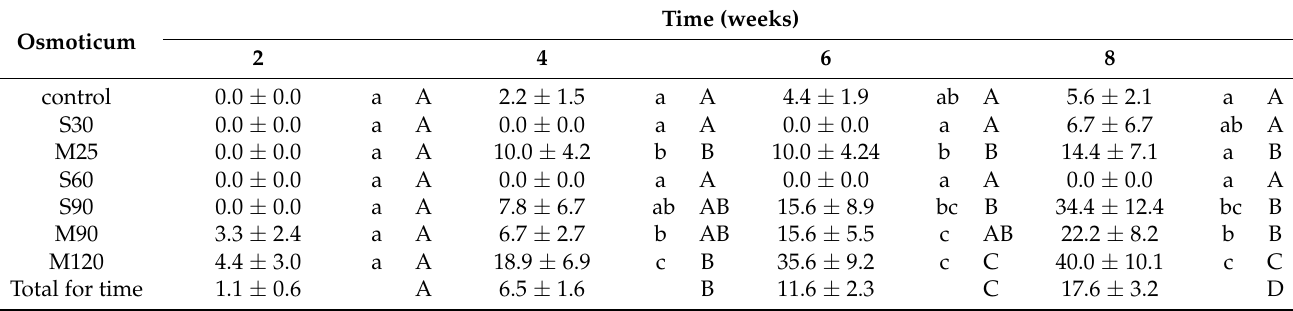
Means with the same lowercase letter within a column or means with the same uppercase letter within a row are not significantly different at p ≤ 0.05; SE—standard